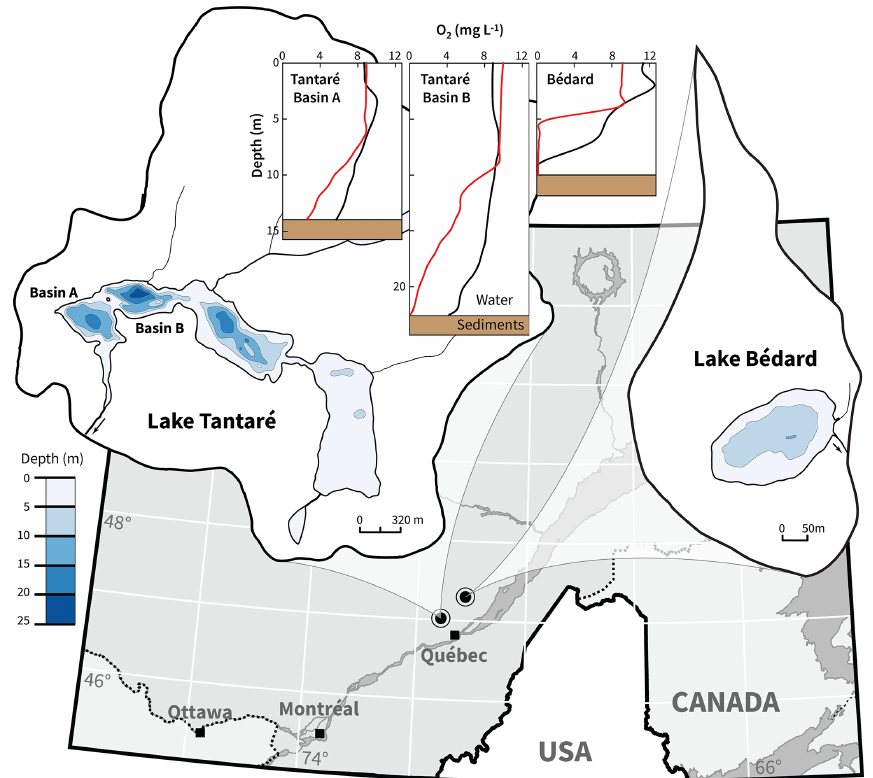
Figure 1. Location map and bathymetry of lakes Tantaré and Bédard. The bathymetric map of Lake Tantaré was reproduced from the map C-9287 of the Service des eaux de surface of the Québec Ministry of Environment. The map of Lake Bédard was reproduced from D’Arcy (1993). Dioxygen concentrations in the water column of Lake Tantaré Basins A and B and of Lake Bédard are given for June (black lines) and October (red lines).